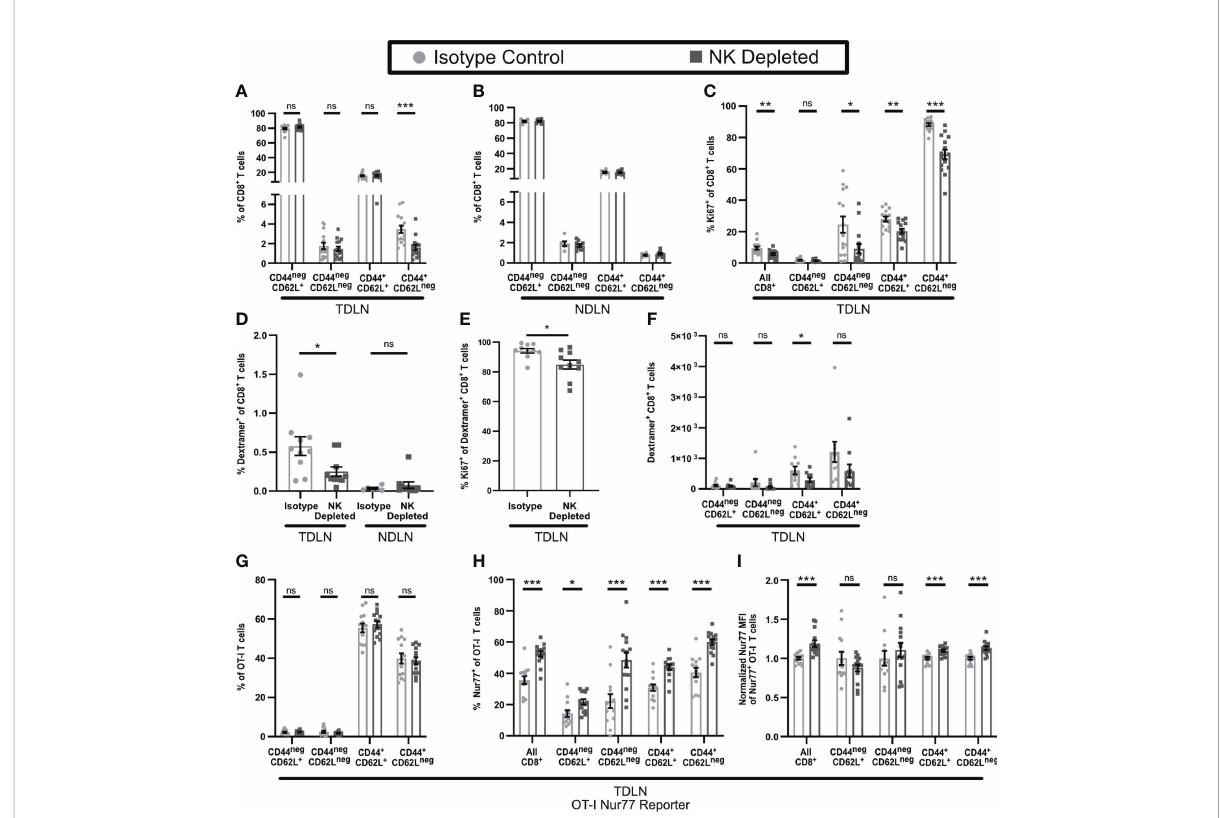
FIGURE 5 T cell activation is altered in the TDLN of mice lacking NK cells. B16-ova tumors were implanted into WT B6 mice treated with isotype control or anti-NK1.1 depleting antibody on D-2, D1, and D4. TDLN (A – H) or NDLN (B, D) were harvested on D7. (A – F) Mice were treated with FTY720 starting on D3 to prevent T cell egress from LN. (G – I) Nur77-GFP + Thy1.1 + OT-I T cells were adoptively transferred into recipient mice prior to tumor implantation to monitor antigen speci fi c TCR signaling. Nur77 MFI was normalized to the isotype control average for each individual experiment. Single cell suspensions were analyzed by fl ow cytometry. Data is from: (A, C) 3 experiments; (B) 2 experiments; (D – F) 2 experiments; (G – I) 2 experiments. Statistics: Unpaired Student ’ s T test with Welch ’ s correction. *p < 0.05; **p < 0.01; ***p < 0.001; ns, not signi fi